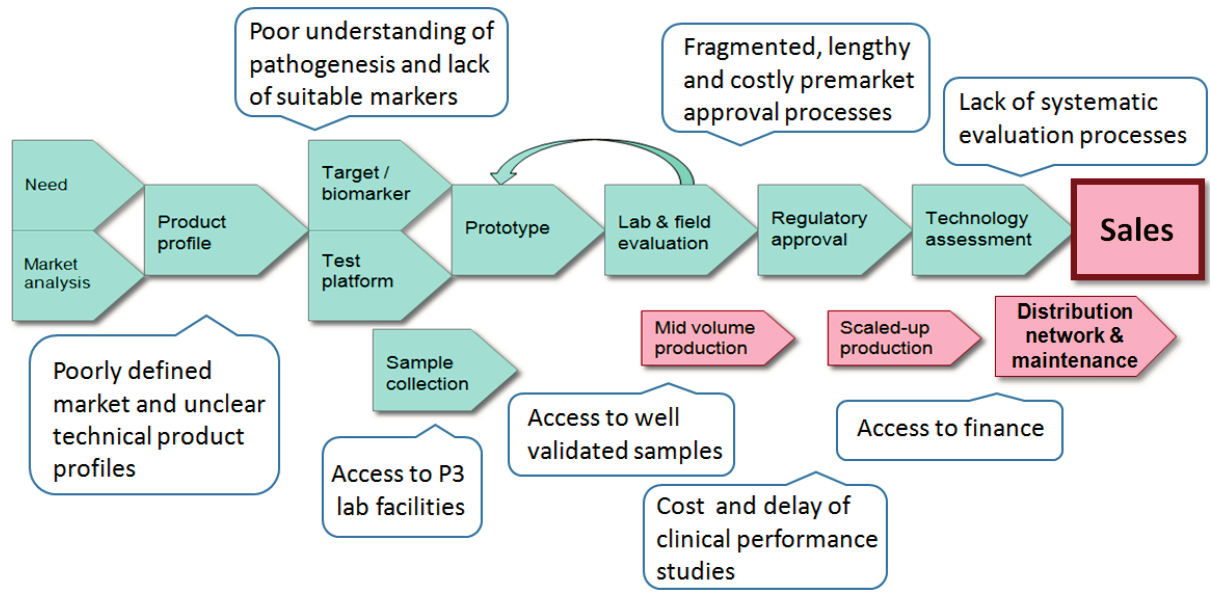
Figure 1. The in vitro diagnostic (IVD) pipeline and obstacles encountered when developing tests for infectious disease in developing